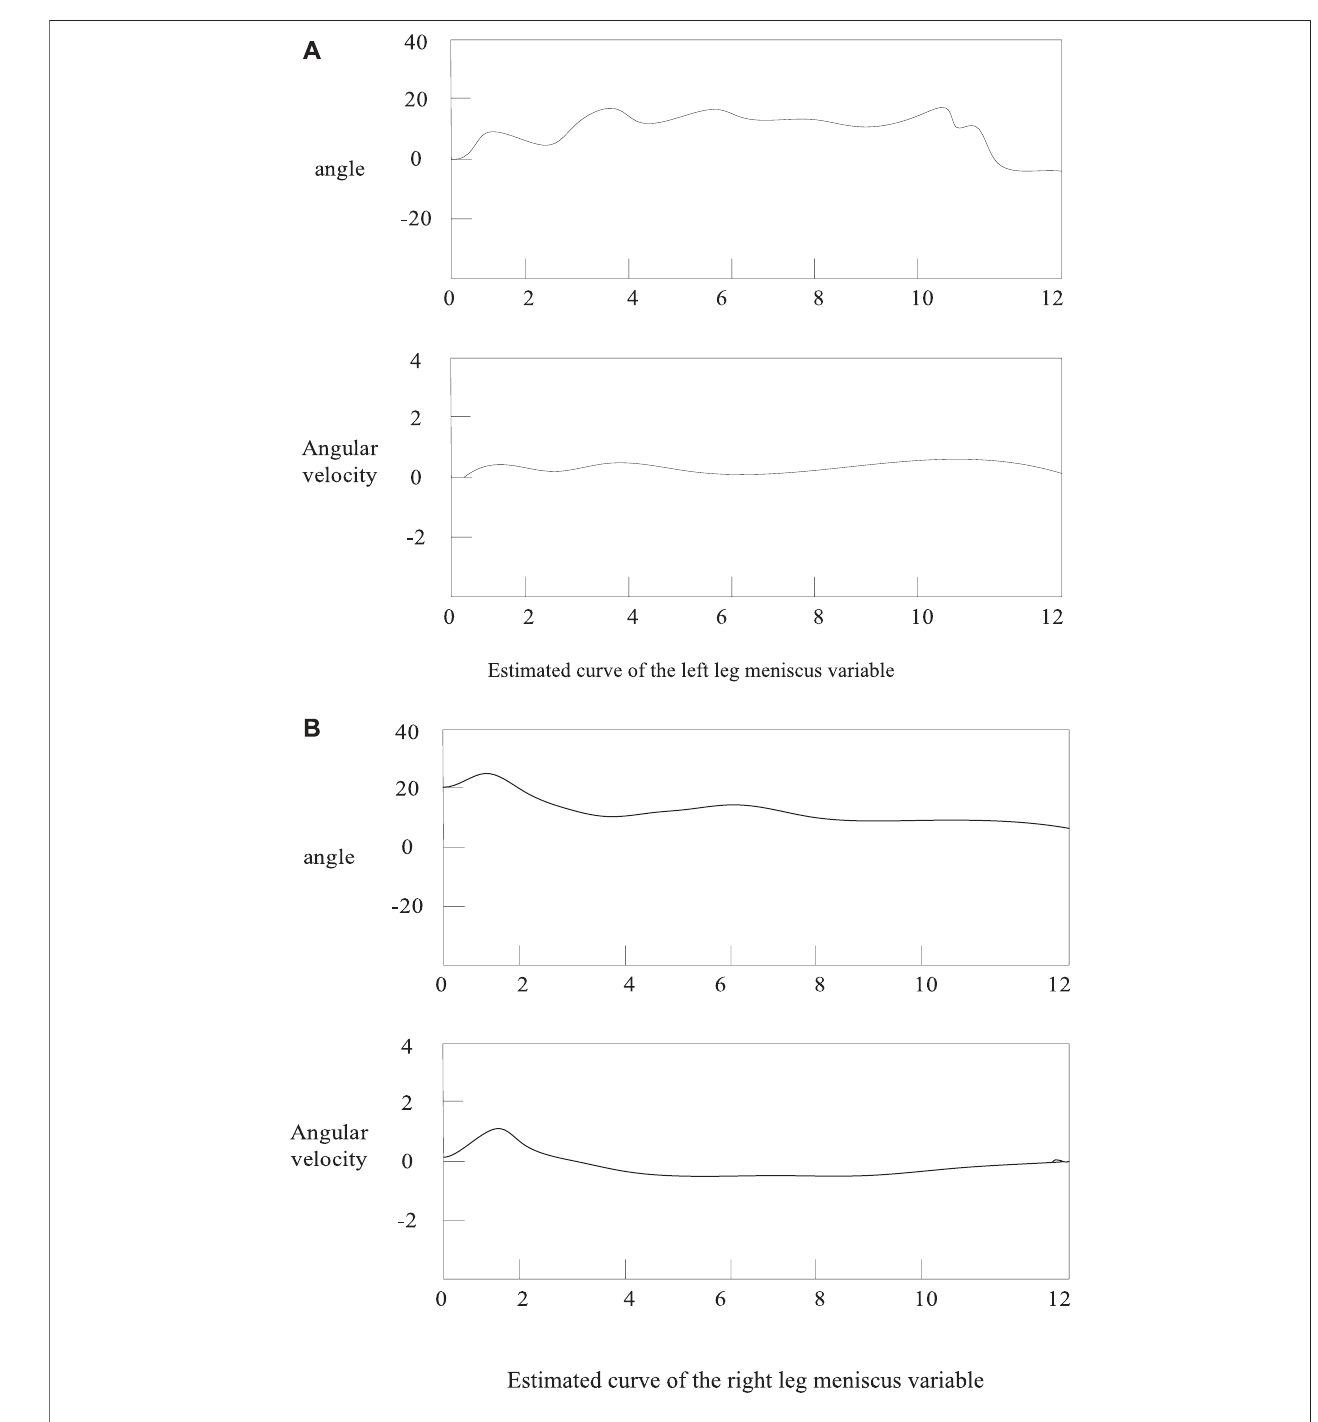
FIGURE 3 | Meniscus variable estimation curve. (A) Estimated curve of the left leg meniscus variable (B) Estimated curve of the right leg meniscus variable.